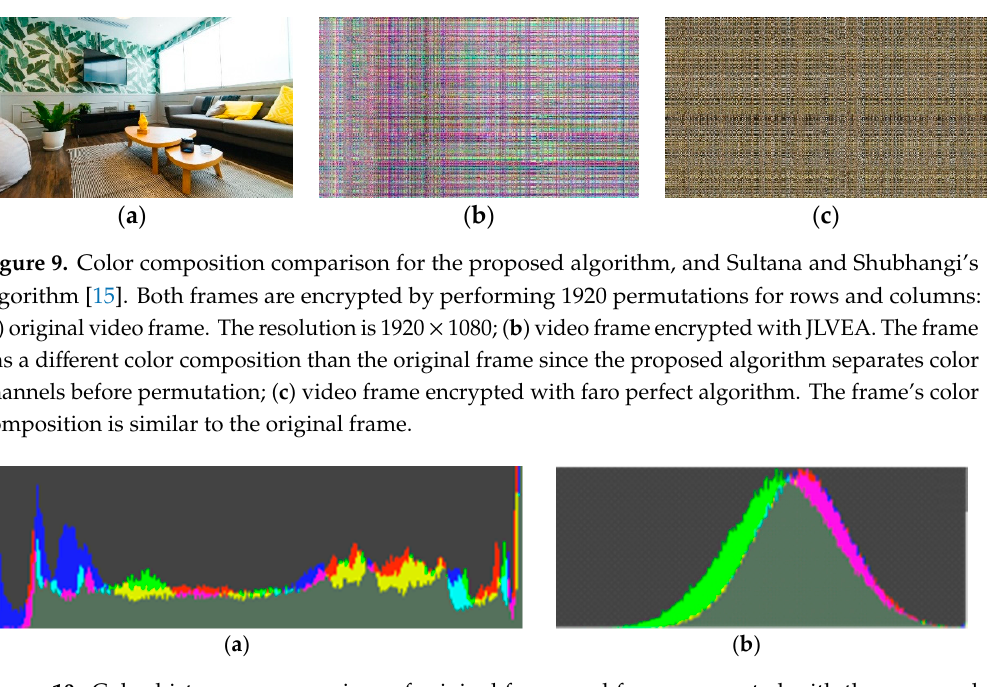
Figure 10. Color histogram comparison of original frame and frame encrypted with the proposed algorithm: ( a ) color histogram of original frame. It has its own specific color distribution; ( b ) color histogram of encrypted frame. Original color distribution has been destroyed.